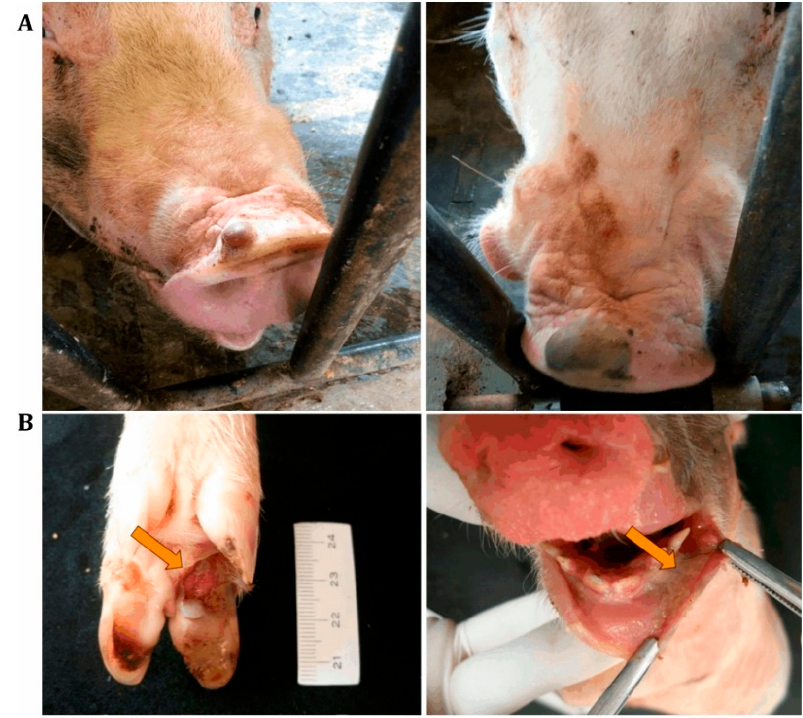
Figure 1. Lesions associated with senecavirus infection. ( A ) Fluid-filled vesicles on the snouts of senecavirus-positive sows. ( B ) Ulcerative lesions on the foot of a three-day-old piglet ( left ) and ulcerative and necrothizing gengivitis in a one-day-old piglet ( right ), both positive for senecavirus [18].